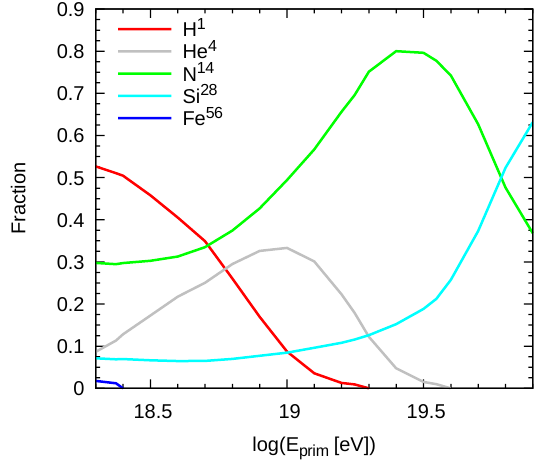
Figure 2. Fractions of ultra-high energy primary cosmic rays entering at the top of the Earth’s atmosphere, as functions of the primary energy, evaluated from partial fluxes corresponding to the combined fit published by the Pierre Auger Observatory [4] (see